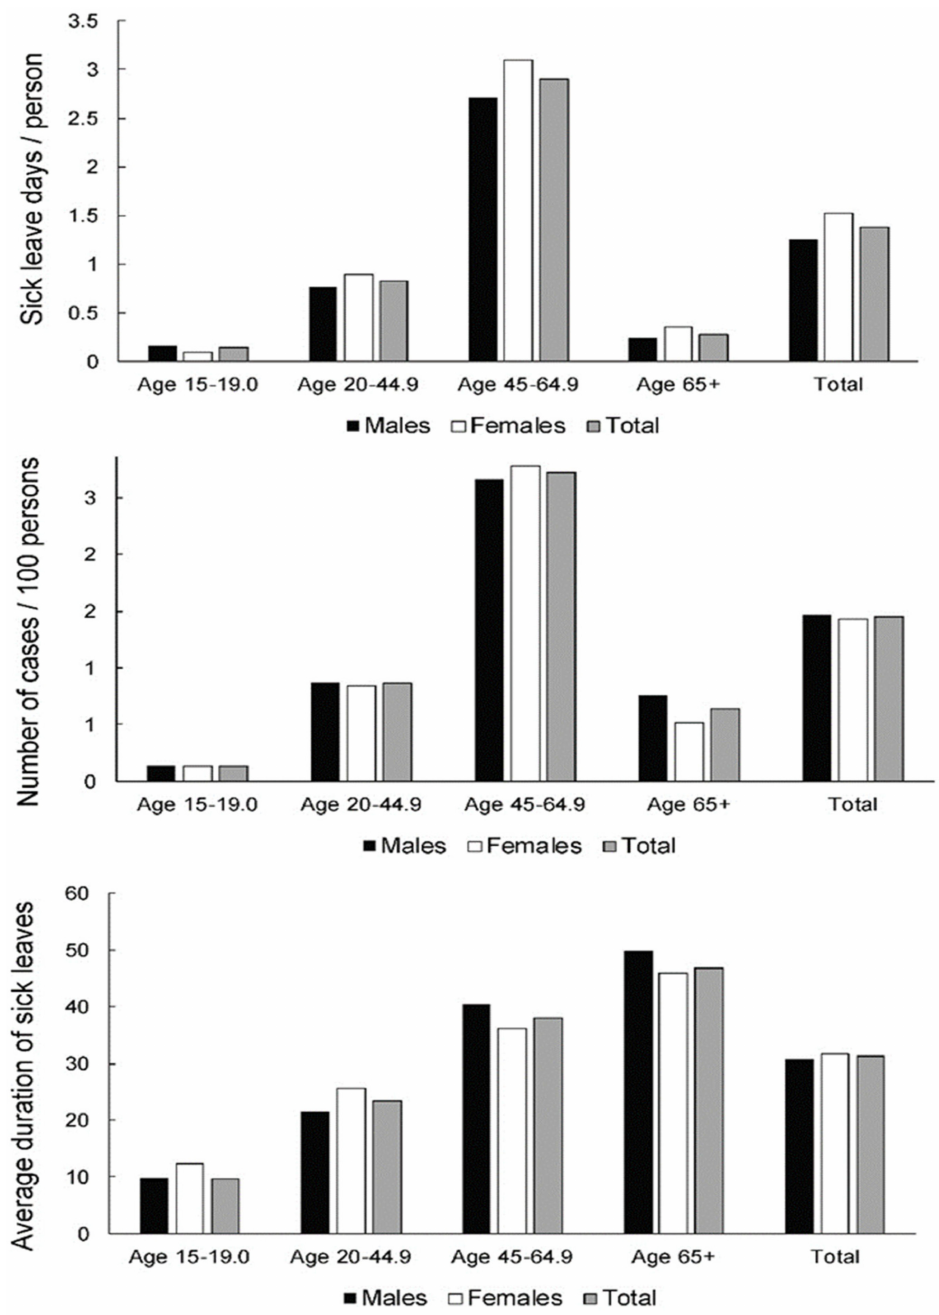
Figure 5. Sick leave days per person (index of temporary disability,) frequency of cases and severity (average case duration) of sick leave across genders and age groups across all economic